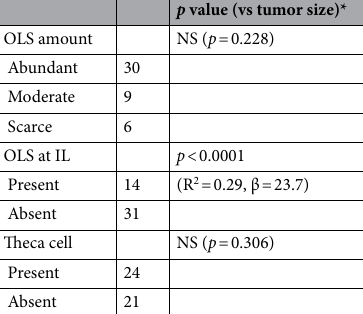
Table 2. The relationship between OLS data and tumor size of pancreatic MCN. * p value, R 2 score (contribution rate), and β-value (coefficient) by regression/logistic analysis were shown. IL, inside the pancreatic lobule; MCN, mucinous cystic neoplasm; OLS, ovarian-like